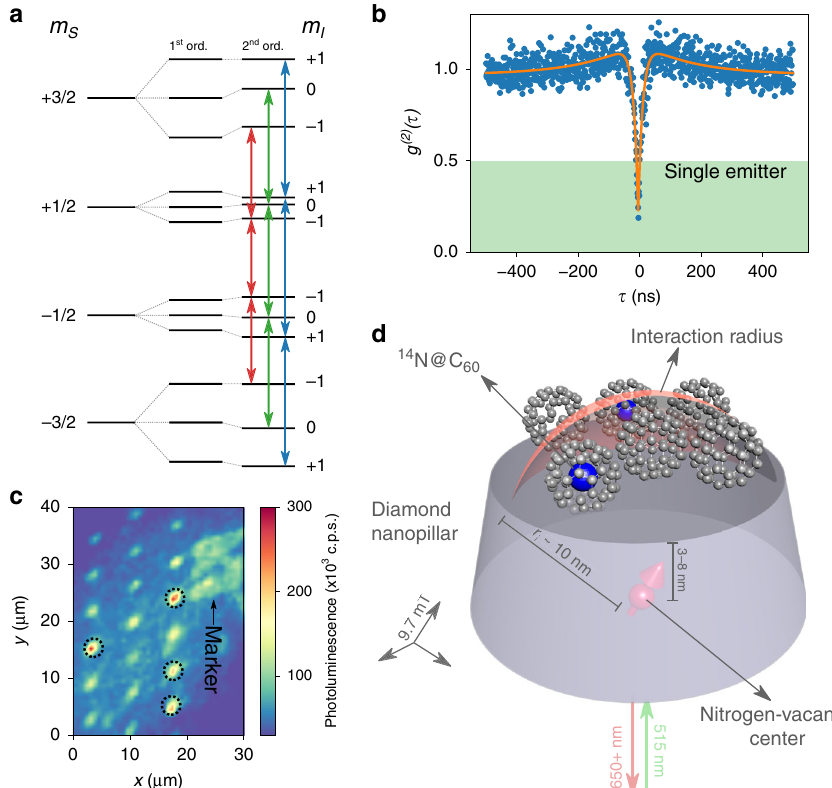
Fig. 1 Schematic of the experiment. a Energy level scheme of 14 N@C 60 ground state ( S = 3/2, I = 1) for a C 60 cage with icosahedral symmetry and second-order corrections of order A 2 /( γ ef B ) ≈ 1 MHz. Colors indicate transitions between spin states with m I = − 1 (red), m I = 0 (green), and m I = − 1 (blue). b Single NV centers identi fi ed using Hanbury Brown – Twiss photon autocorrelation with g 2 (0) < 0.5 (shaded region). c Confocal image of red fl uorescence from N@C 60 -coated diamond nanopillar arrays showing several luminescent single NV centers (dotted circles) at cryogenic conditions. The diamond surface is labeled with markers to probe the same NV site at different experimental conditions. d Schematic of a single near-surface NV center with a disordered network of empty and fi lled C 60 cages within its interaction